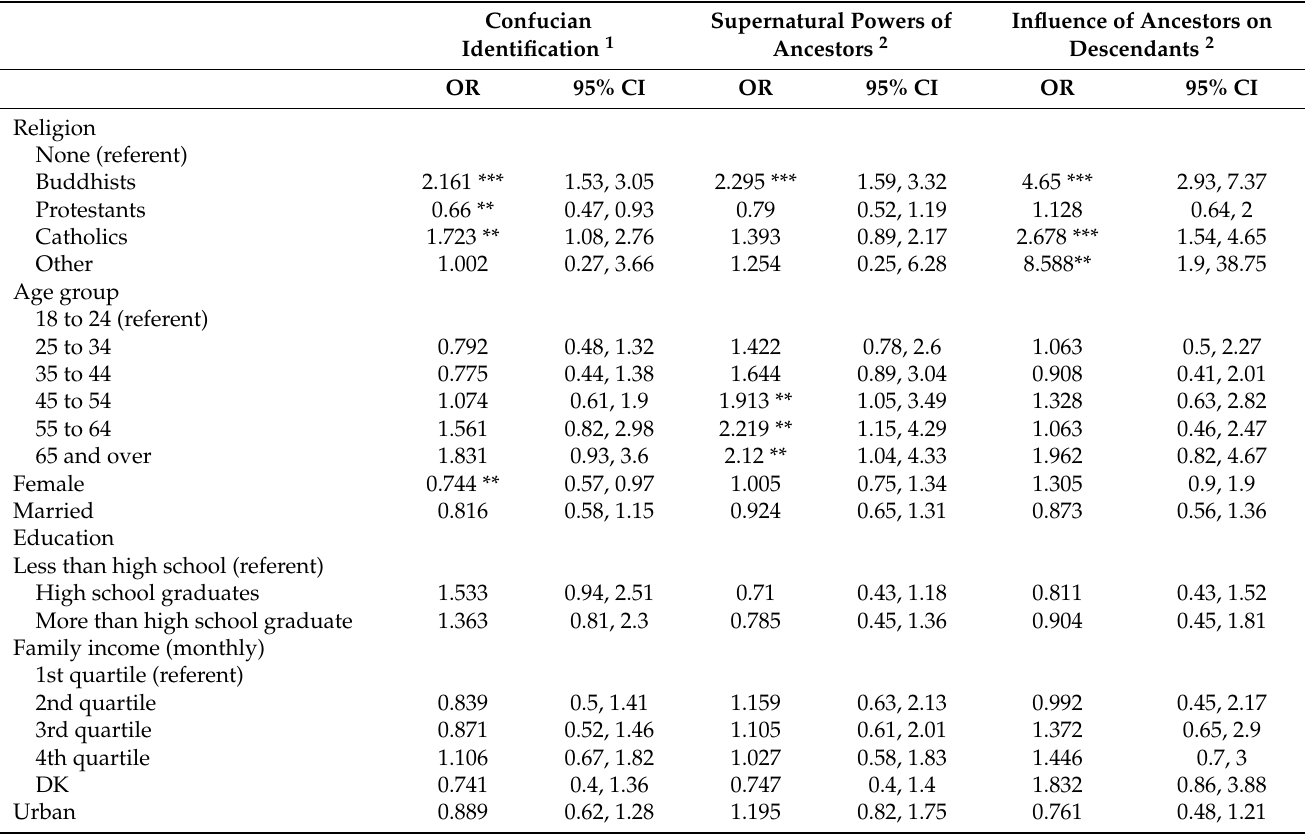
Table A1. Results of binary logistic regression on Confucian identification, beliefs, and practices.